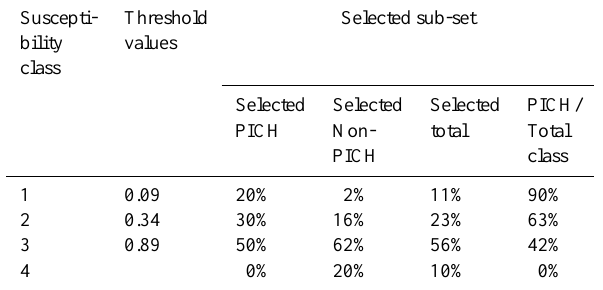
Table 2. Illustration of the efficiency of a sorting based on the discharge ratio. Suscepti- Selected sub-set